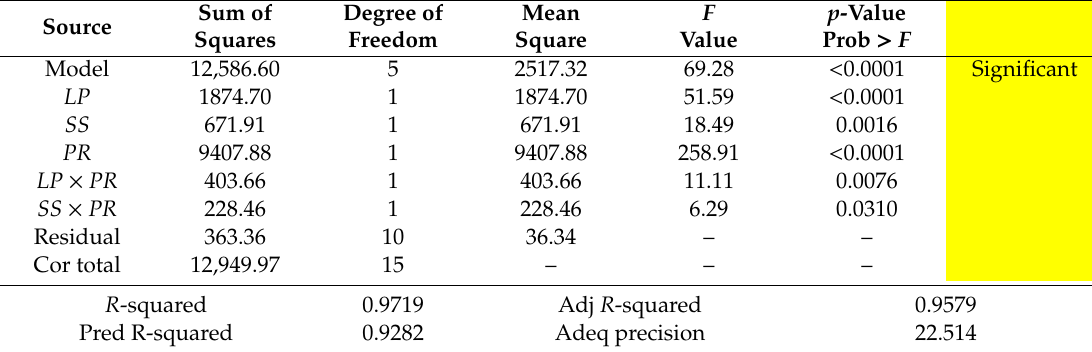
Table 5. Cladding e ffi ciency variance analysis